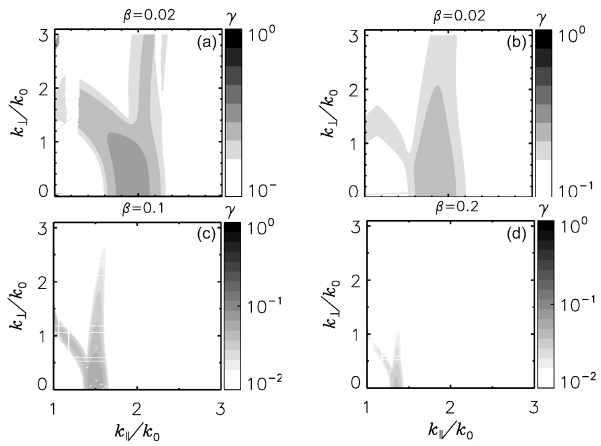
Figure 2. (a, b) Map of the growth rates in the k (cid:107) − k ⊥ wavenumber domain for right- (a) and left-handed (b) polarization of the Alfvén pump wave corresponding to the analysis shown in Fig. 1 at plasma β = 0 . 02. (c, d) Diagrams for left-handed polarized Alfvén pump wave at higher beta